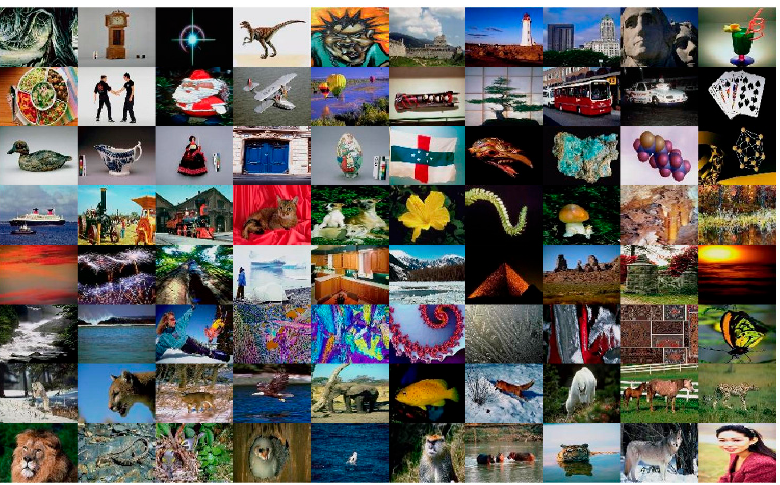
Figure 12. Sample image from each category in Corel-DB80 dataset.